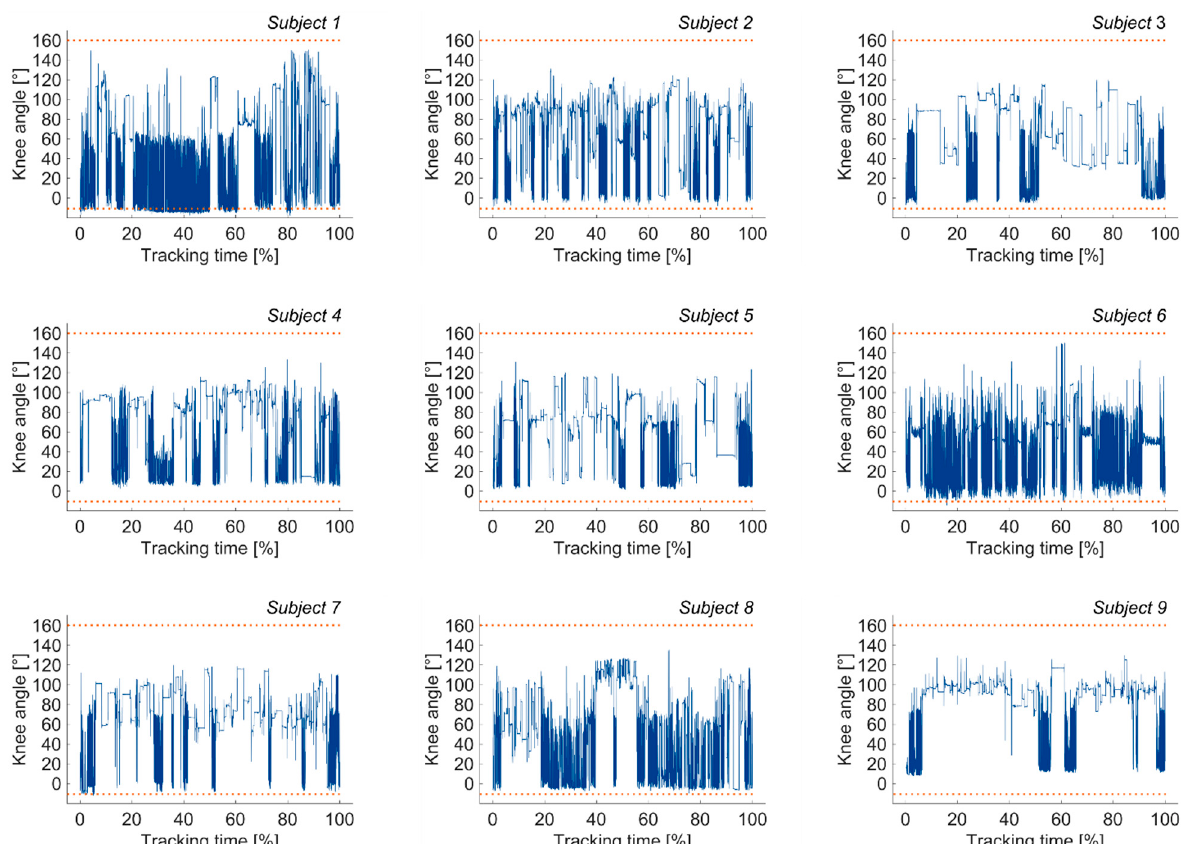
Figure 6. Continuously tracked sagittal knee angle data for subjects 1 through 9; the blue line represents the sagittal knee angle and the dotted orange lines mark the limits of − 10° knee extension and 160° knee flexion.